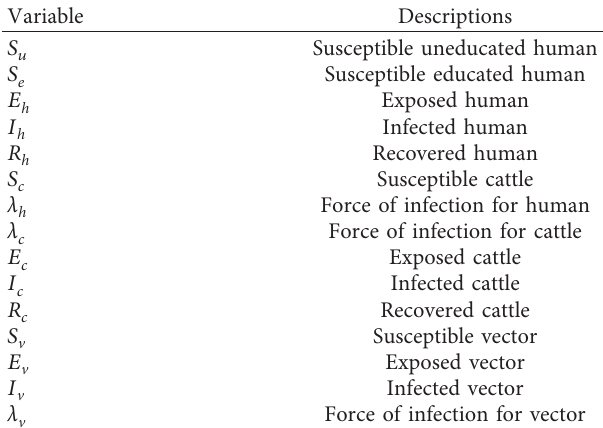
Table 1: Descriptions of variables of model